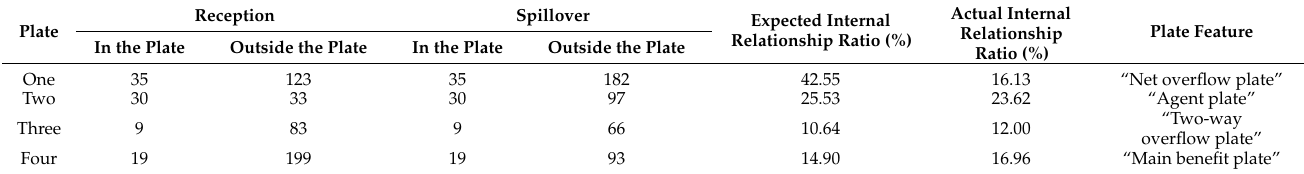
Table 6. Correlations for eco-efficiency between plates in